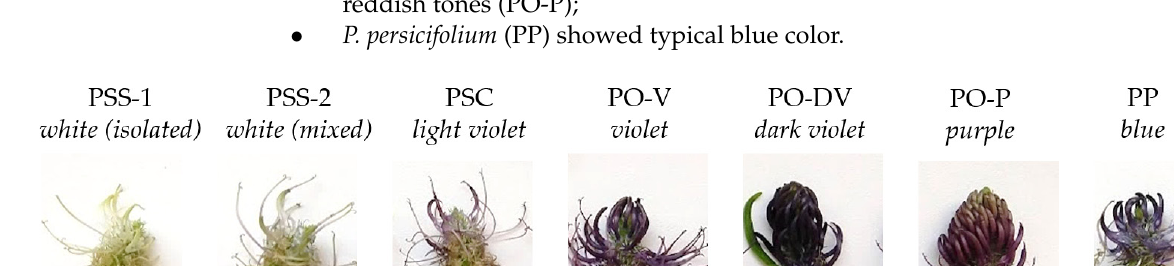
Table 1. Colorimetric variables (mean ± SD) for different populations of Phyteuma , indicating L (lightness), h ◦ (hue angle), a and b green–red and blue–yellow scale) and C* (intensity). Different letters indicate statistical differences between populations.